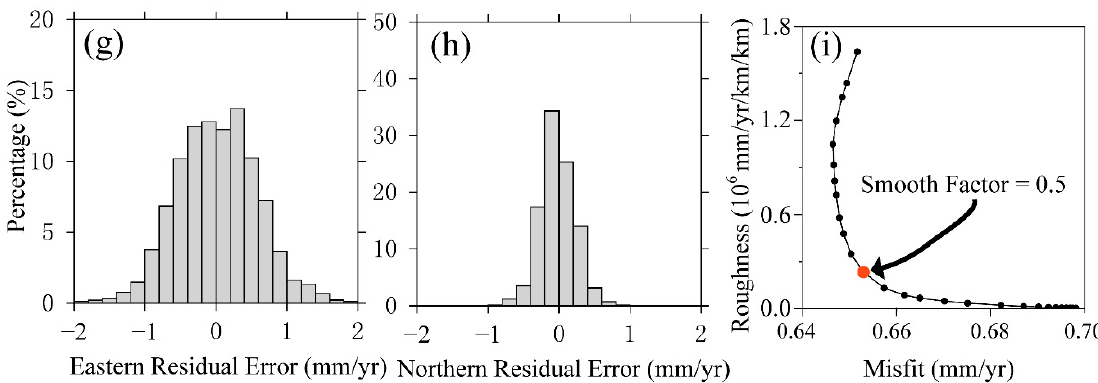
Figure 6. Data fitting and error statistics for the optimal interseismic fault slip model. ( a ) Original and ( b ) predicted E–W velocities and ( c ) the residual of the E–W velocity. ( d ) Observed, ( e ) predicted, and ( f ) residual values of the N–S velocity. ( g ) Residual statistical distribution of the E–W velocity. ( h ) Residual statistical distribution of the N–S velocity. ( i ) The L-curve selected for the smoothing factor in the inversion model. The red dot represents the optimal smoothing factor.